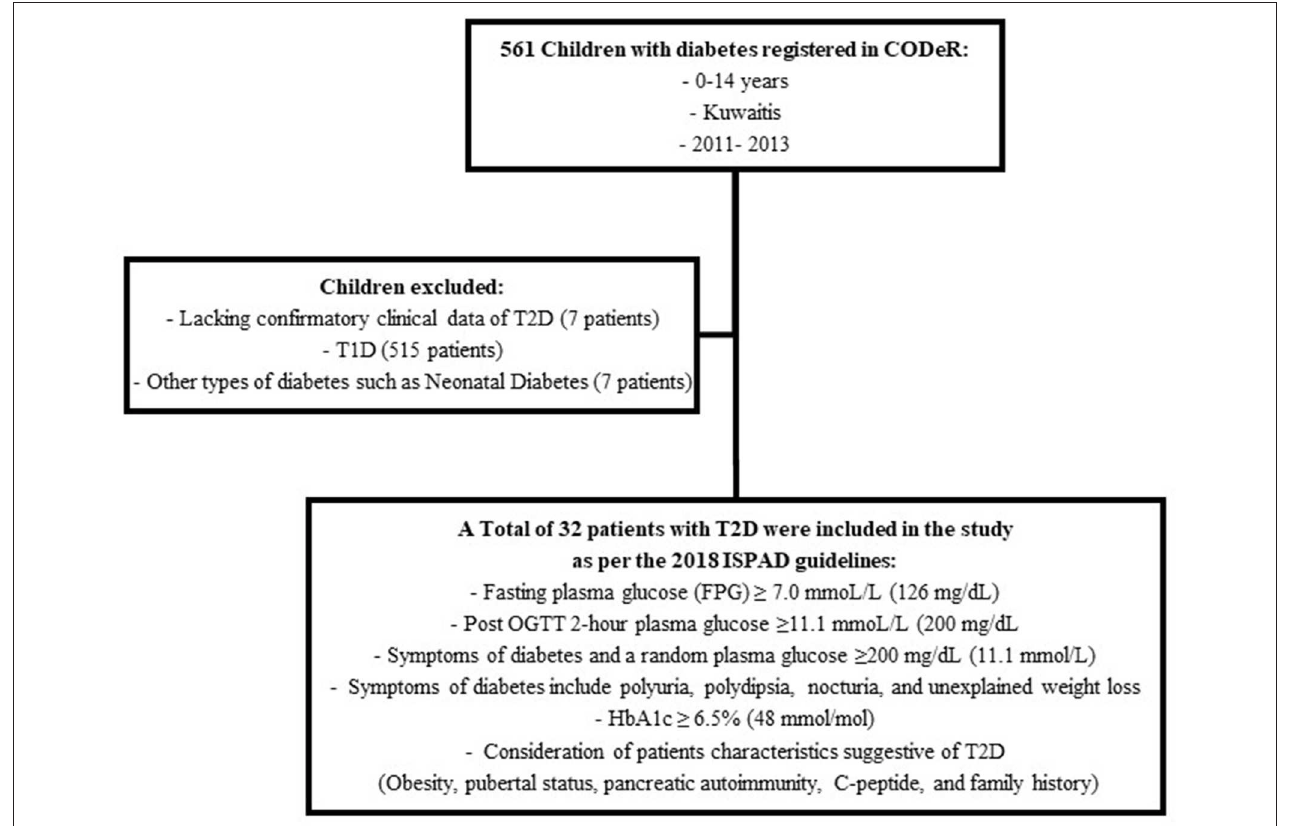
FIGURE 1 | Diagnosis of T2D in children and adolescents registered in CODeR.